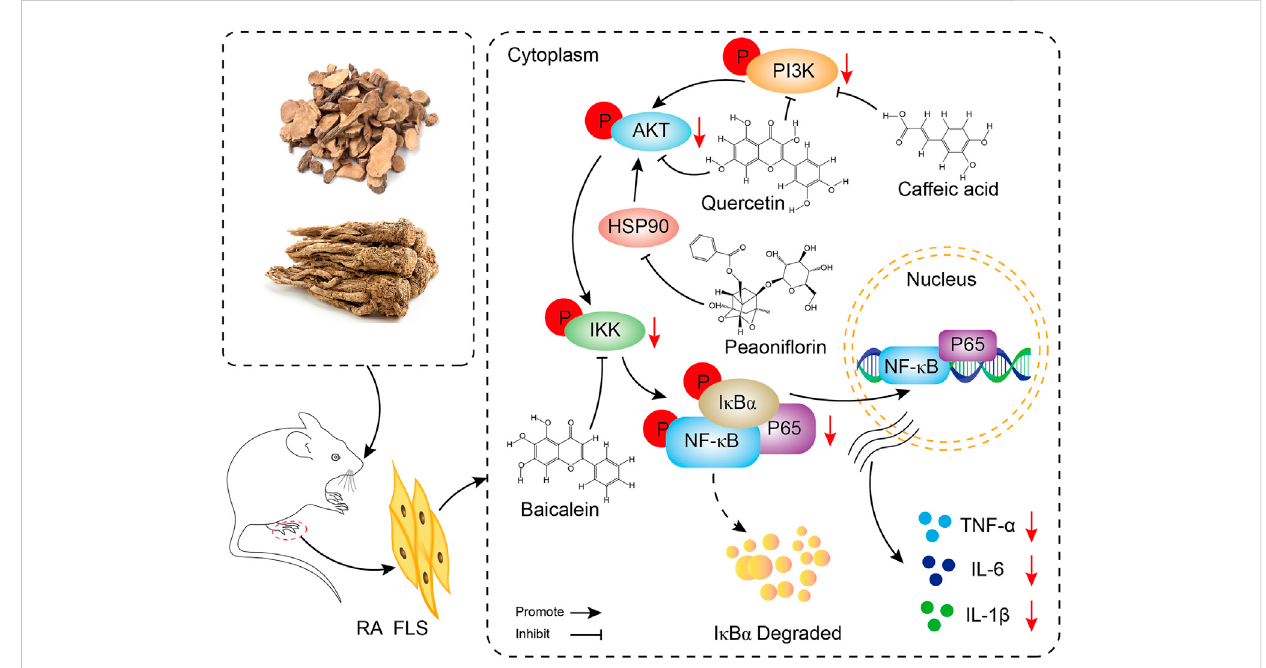
FIGURE 10 Mechanism display of P-A drug pair in the treatment of RA through PI3K/AKT/NF- κ B signaling